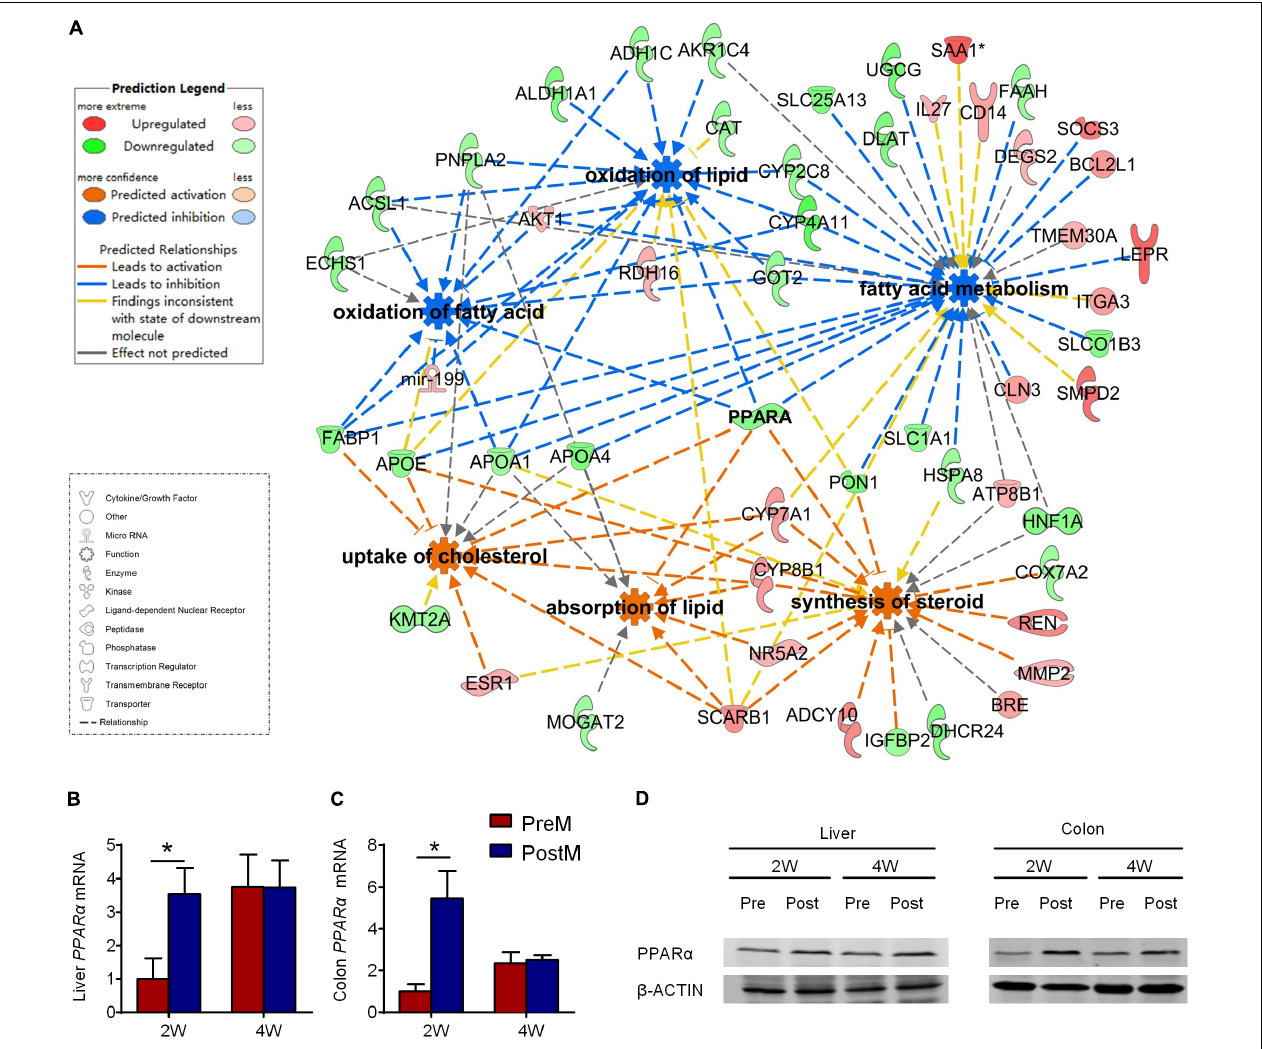
FIGURE 5 | The hepatic transcriptional profile of lipid metabolism in gnotobiotic mice. (A) IPA ingenuity interaction network of six significantly modulated biological functions (circle with eight arises) and 53 DEGs (configuration corresponding to the type of gene product as showed in the lower figure legend) related to lipid metabolism in liver on the 2 nd week. As showed in the upper legend, DEGs with red color represent for upregulated while green color represent for downregulated in PreM group compared to PostM group, biological functions with blue color are predicted to be significantly repressed, while orange color are predicted to be significantly activated in PreM group compared to PostM group. Lines represent the relationship between the biological functions and DEGs. (B) RT-PCR of ppar α expression in liver. (C) RT-PCR of ppar α expression in colon. The relative expression of Ppar α was adjusted with Gapdh as the housekeeping gene. (D) Western blot of PPAR α and β -ACTIN in liver and colon. Data are shown as the mean ± SEM and were analyzed by the Mann–Whitney U test between groups; ∗ P < 0.05. n = 4 or 5 for each group. The details of the DEGs refer to Supplementary Table